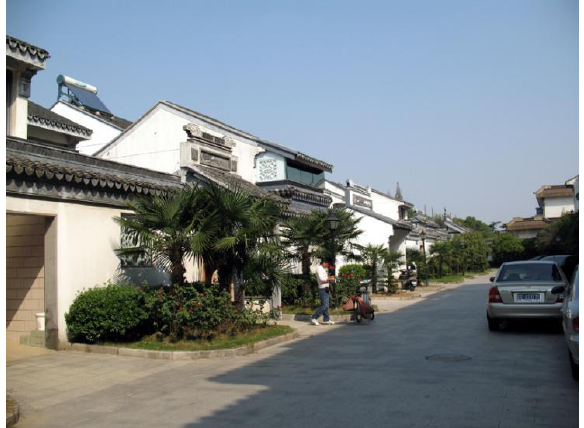
Figure 6. The Chinese-style new courtyard housing at Suzhou Jiaanbieyuan. Photo: Donia Zhang 2007